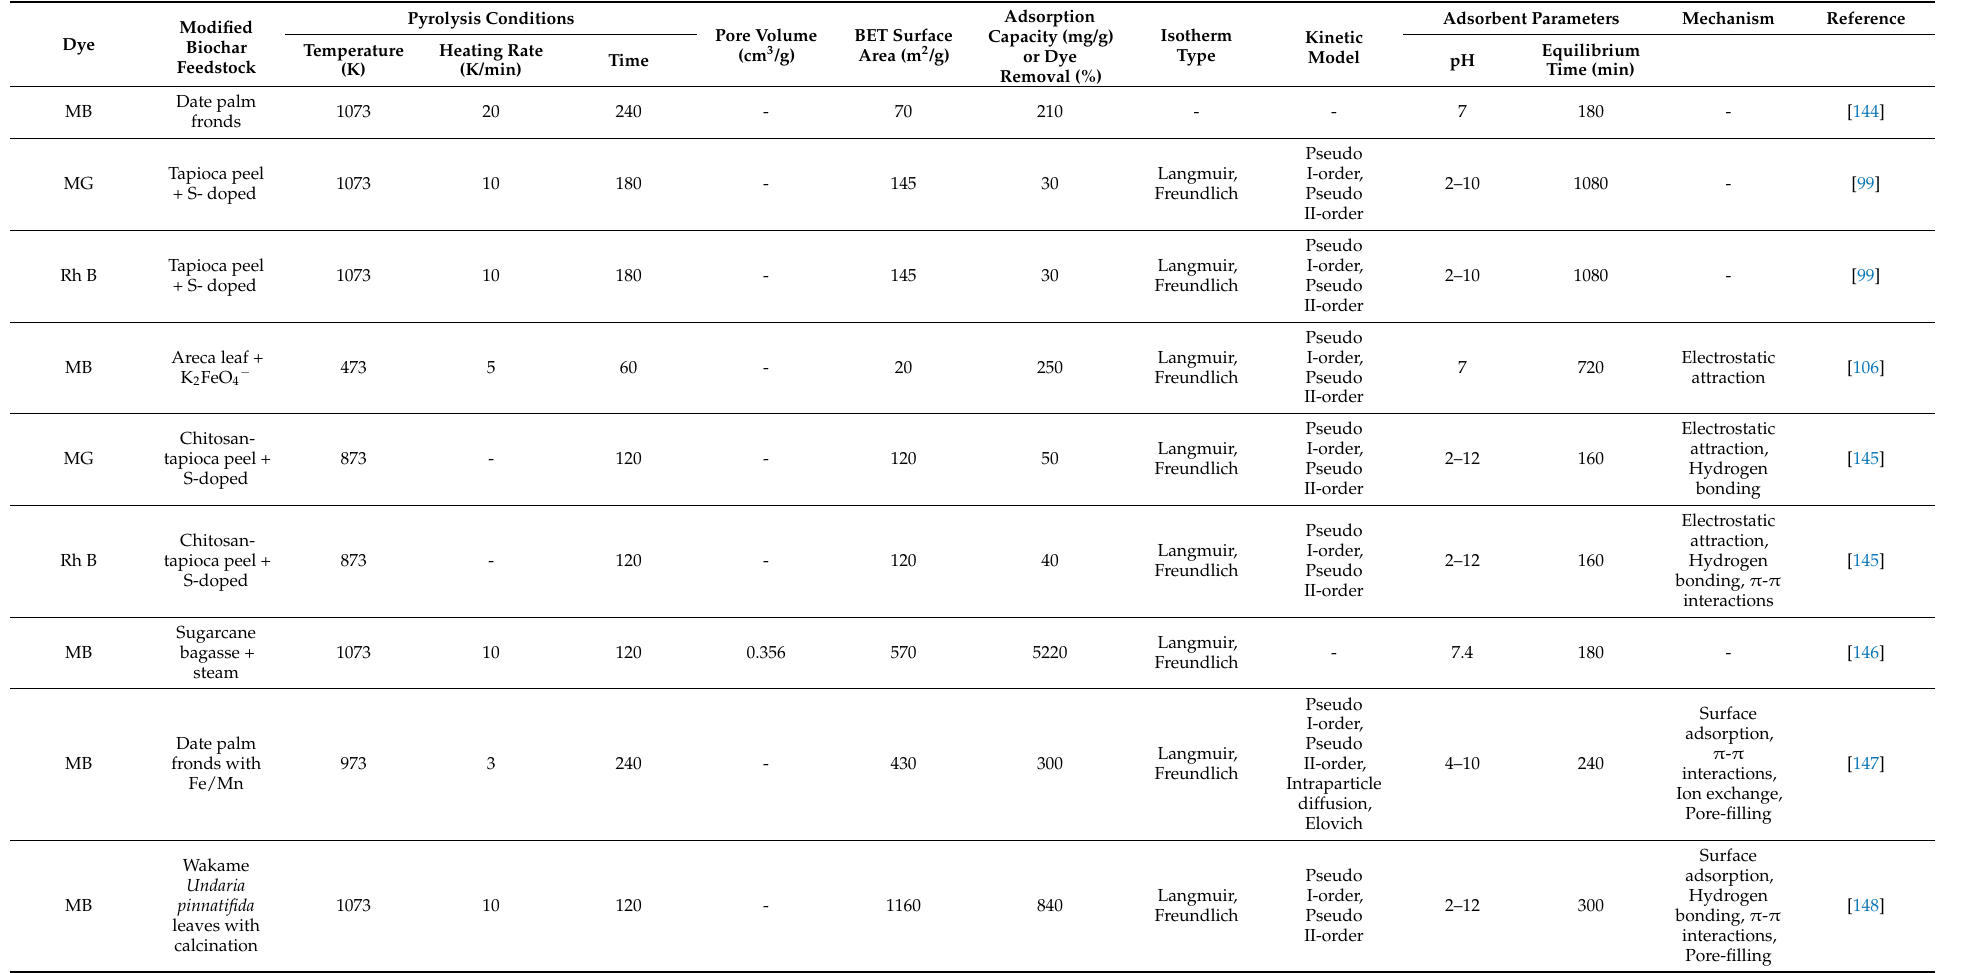
Table 3. Basic dyes (cationic) and their adsorption onto modified (altered)